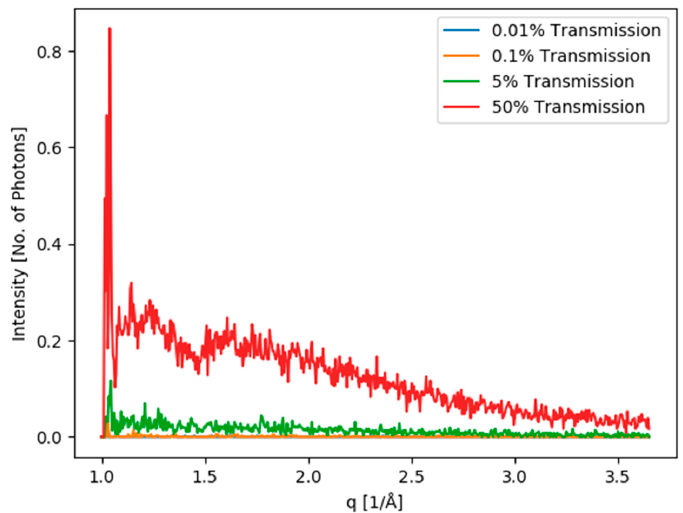
Figure 3. Radial average of the X-ray diffraction intensities determined at 1 kHz operational frequency of frame readout of the Eiger X 1M detector for different transmissions and in the lack of protein crystals, i.e., the background coming from the air scattering and other factors. Y-axis gives the radial average of photons counted by the detector per 1 ms exposure time per frame. The average is calculated for one typical background frame.